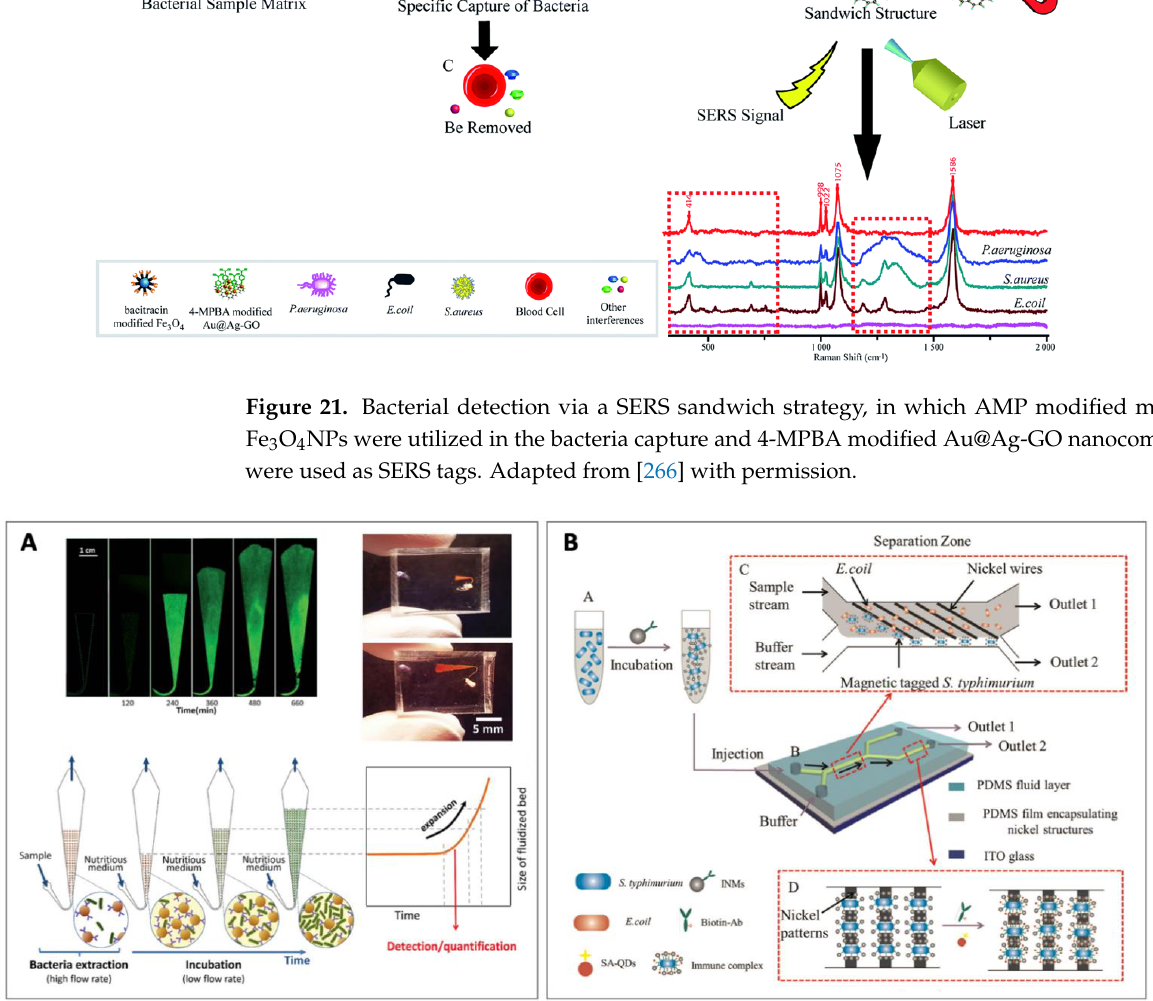
Figure 22. Microfluidic platforms for pathogenic bacteria detection. ( A ) Bacterial detection using a microfluidic fluidized bed. Quantitative detection can be performed by measuring the bed expansion. Reprinted with permission from [284]. ( B ) Microfluidic device integrating a magnetic separation stage and a detection stage based on magnetic target capture and sandwich assay.